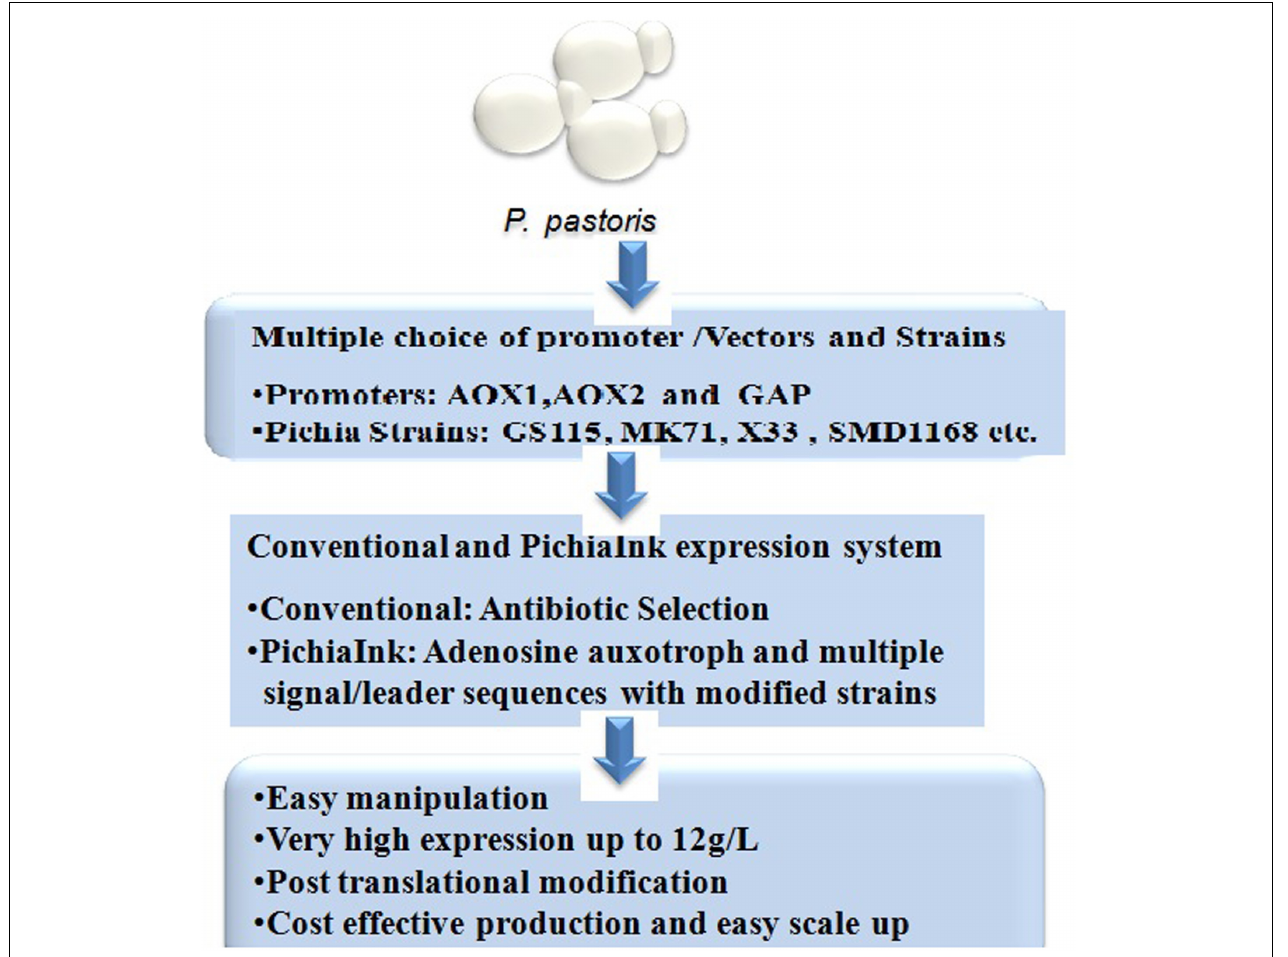
FIGURE 2 | P. pastoris expression system and its